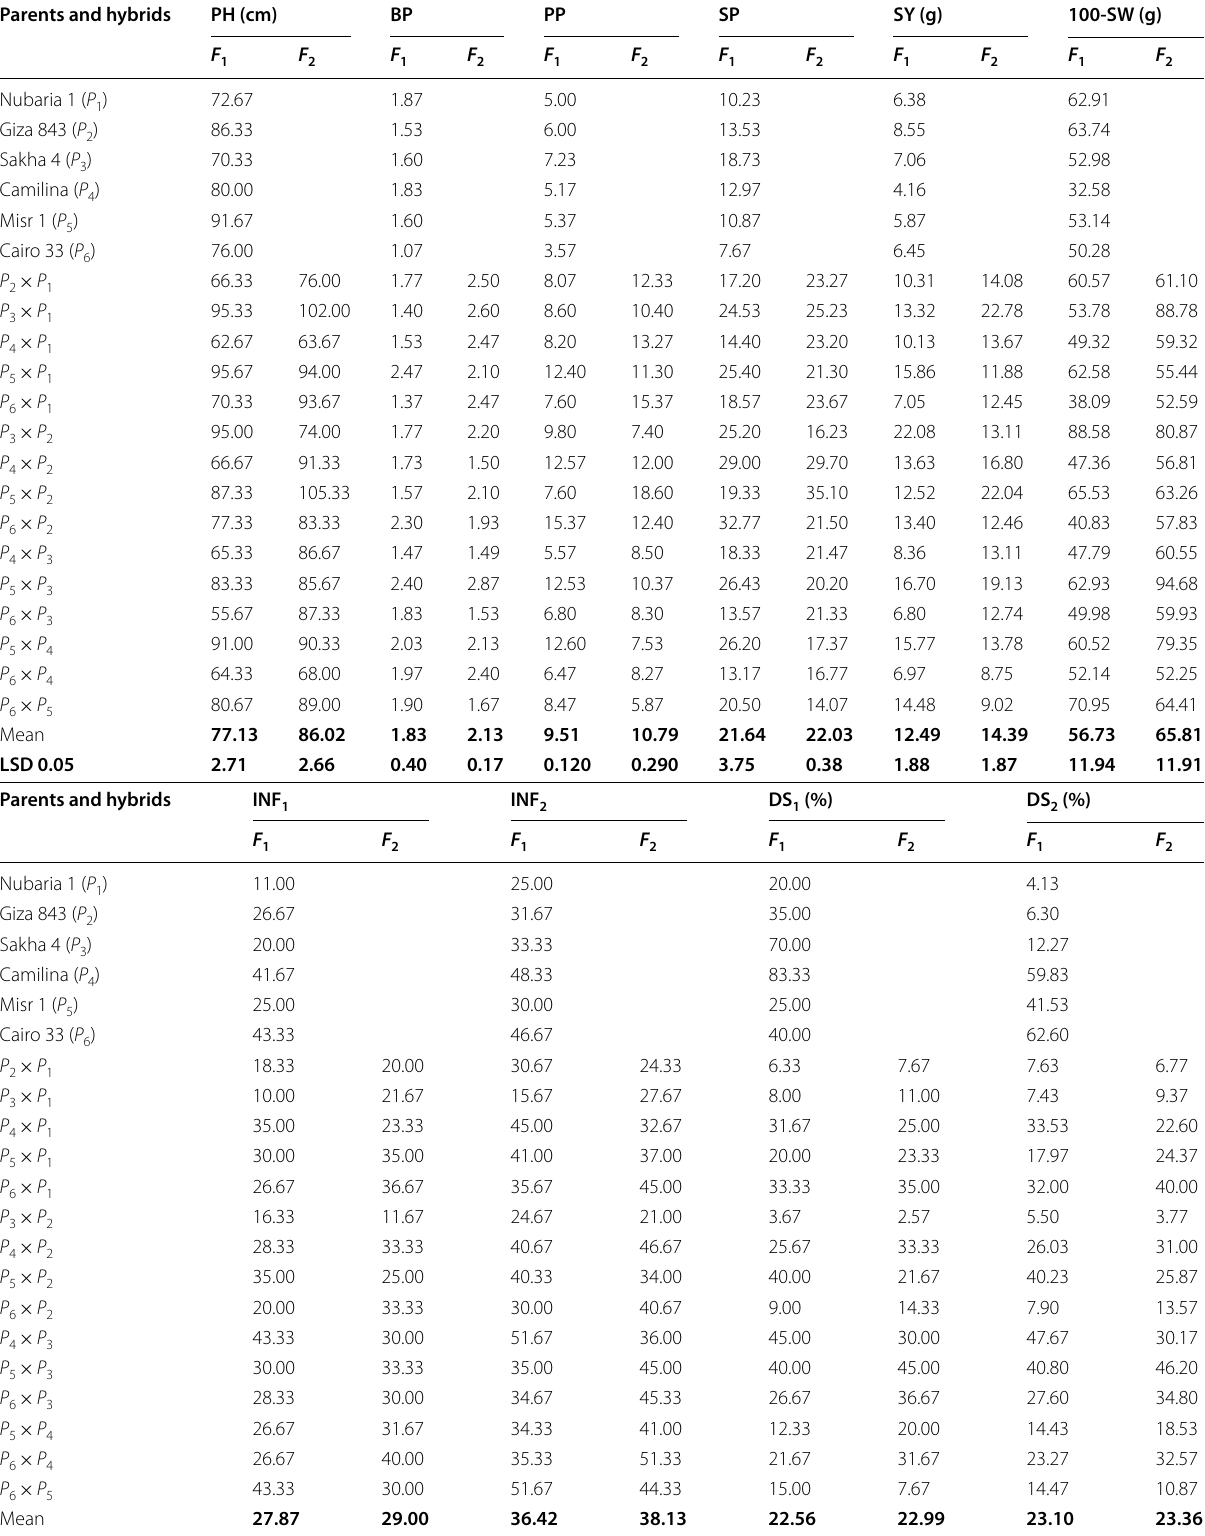
and F ) for various studied traits 1 2